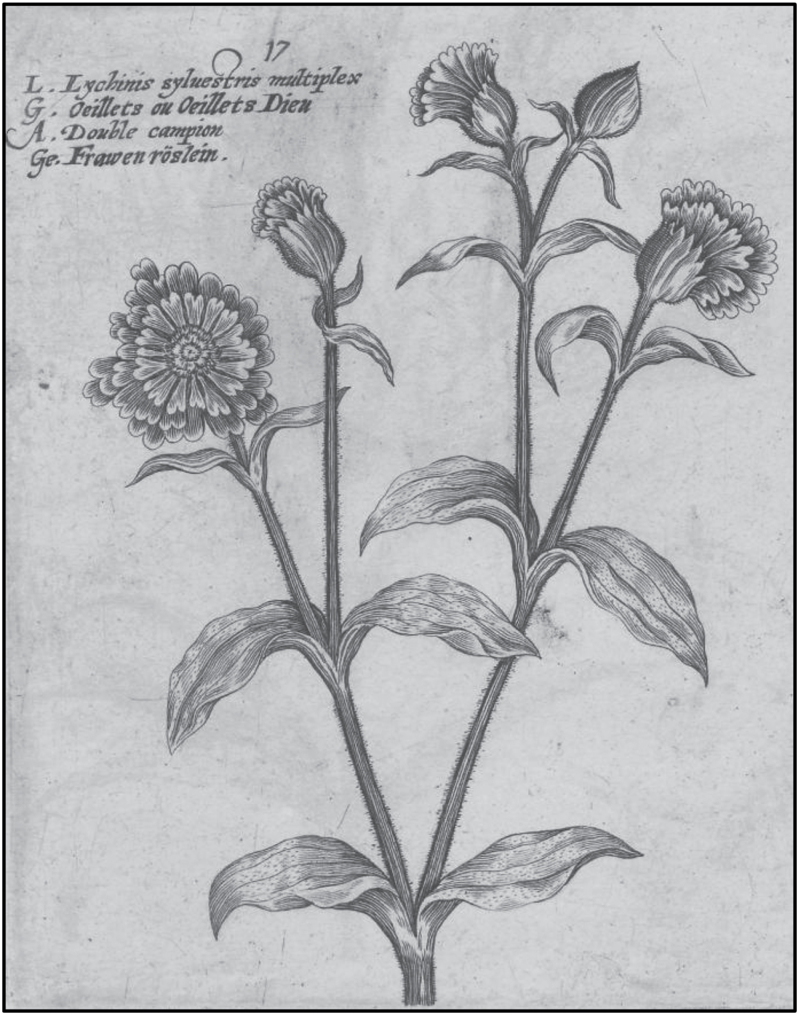
Seventeenth century engraving of double-flowered S. dioica.
Engraving of double-flowered S. dioica from Hortus Floridus, Altera Pars (van de Passe, 1605) courtesy of Utrecht University Library.